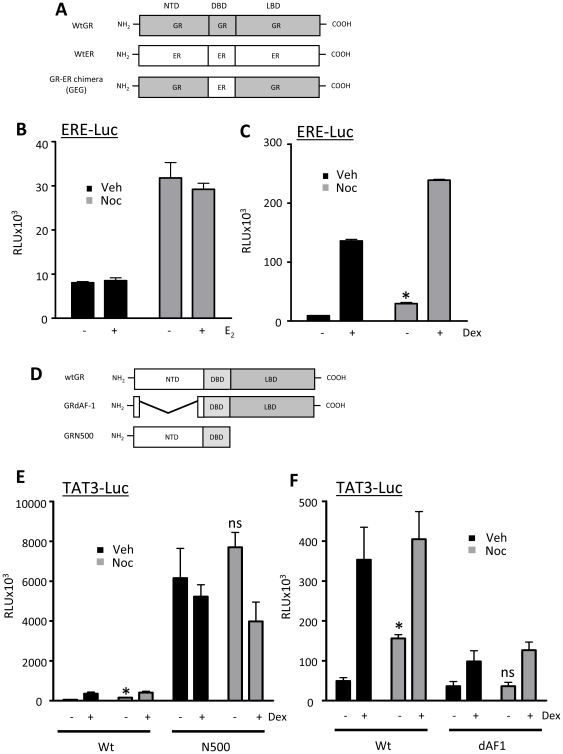
GR N-terminal is regulated by mitosis.(A) A GR-ER chimera was used which comprises the GR N- and C-terminus and the ER DNA binding domain. (B, C) HeLa cells were co-transfected with a receptor chimera (GEG), together with 1 µg of the estrogen receptor responsive reporter ERE-Luc and 0.5 µg CMV-renilla (to control for transfection efficiency). 24 hours later, cells were treated with vehicle or nocodazole for 16 hours, then washed and treated with vehicle, estradiol or dex for 16 hours. Cells were lysed, harvested and assayed for luciferase activity using a dual-luciferase reporter assay system. (D) Two deletion mutant receptors were used which lack either the C-terminal ligand binding domain (GRN500) or the AF-1 domain within the N-terminus (GRdAF1). To minimise confounding effects of wildtype endogenous GR in HeLa cells, GR deficient HEK cells were used in this instance. HEK cells were co-transfected with 1 µg TAT3-Luc and 0.5 µg CMV-renilla (to control for transfection efficiency) together with either 1 µg full length GR, GRN500, (E), or GRdAF1 (F). 24 hours later, cells were treated with vehicle or nocodazole for 16 hours, then washed and treated with vehicle or dex for 16 hours. Cells were lysed, harvested and assayed for luciferase activity using a dual-luciferase reporter assay system. Graphs depict mean +/− SEM and are representative of three independent triplicate experiments. * indicates p<0.05 compared to vehicle control.